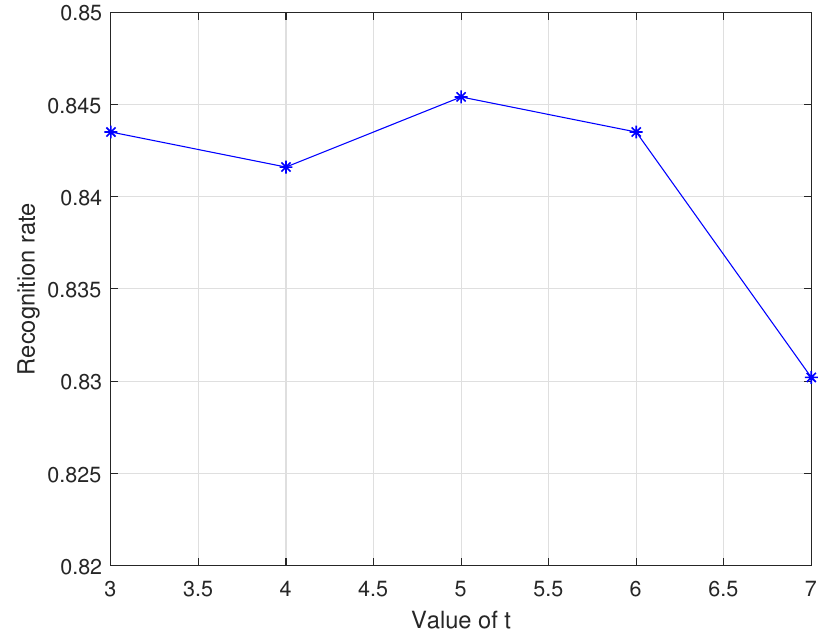
Figure 9. Recognition rates of different